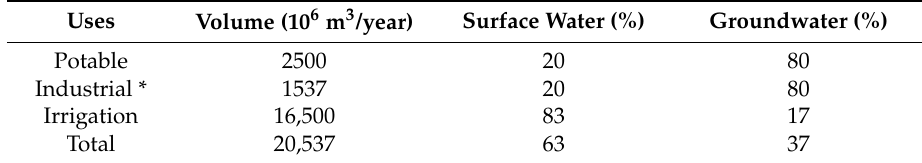
Table 1. Annual average water uses by sources. Legend (* energy production excluded) [41]. Uses Volume (10 6 m 3 /year) Surface Water